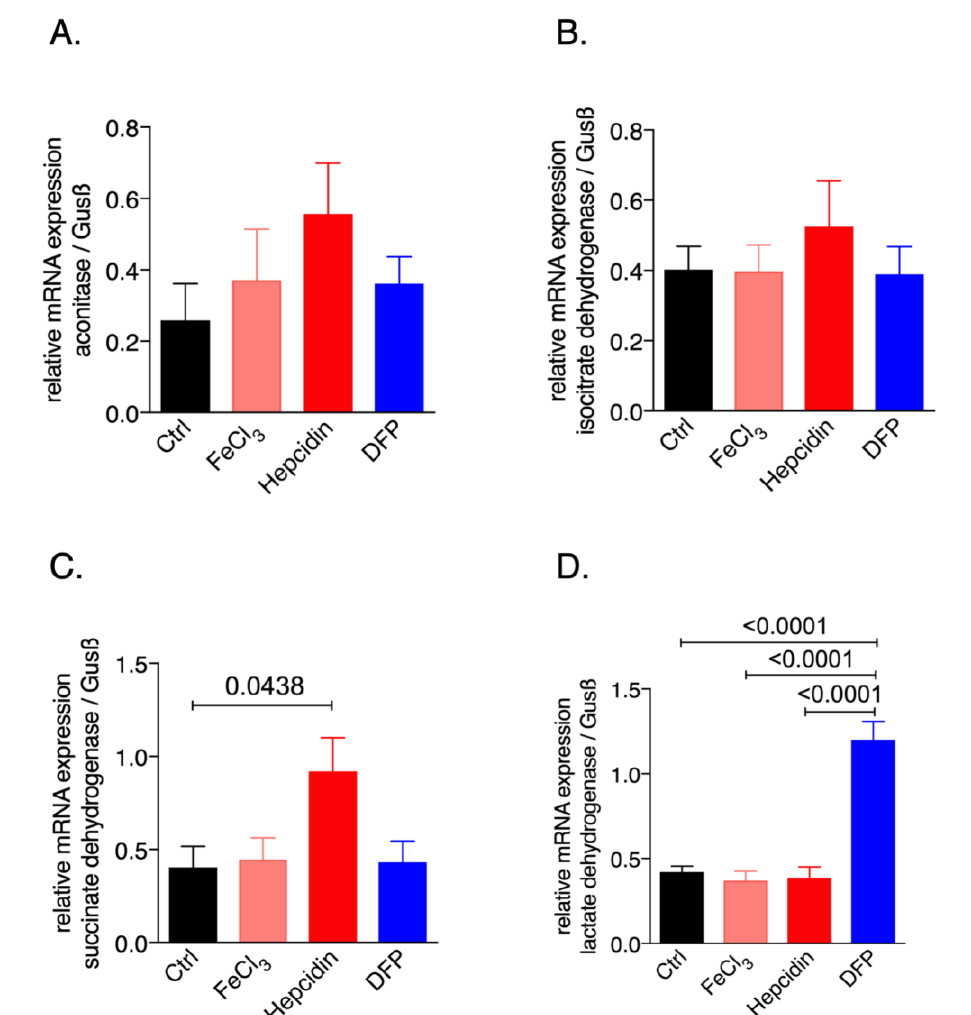
FIGURE 1: Effects of macro- phage iron loading on